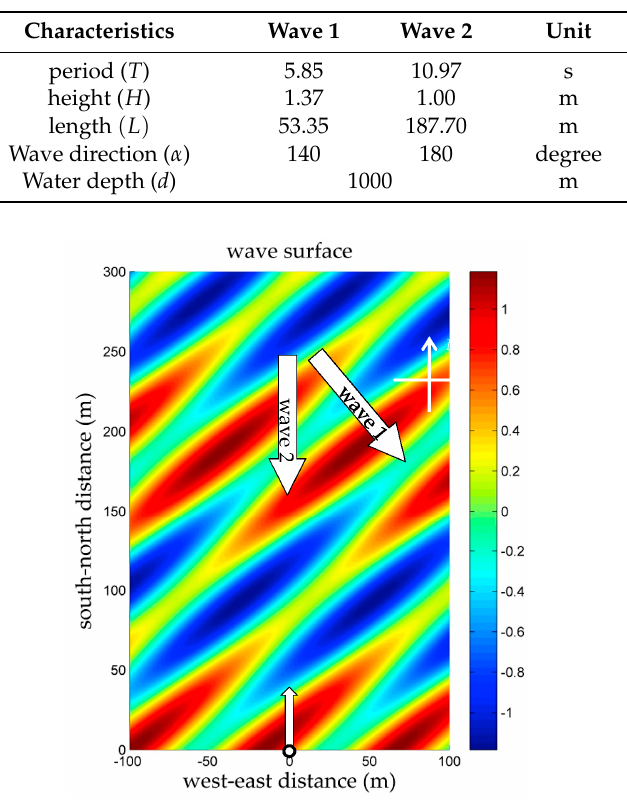
Figure 18. Two ocean waves. The highest points and the lowest points are 1.185 m and − 1.185 m and located in the dark red areas and the dark blue areas, respectively.